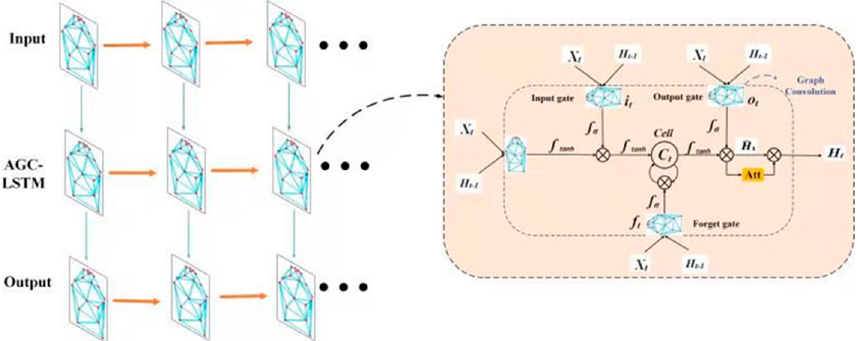
Figure 1. The structure of one ASTGC-LSTM layer.